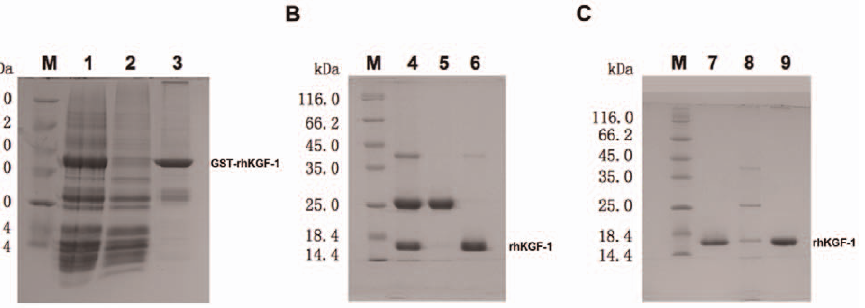
Figure 1. SDS-PAGE analysis of expression and purification of rhKGF-1. Panel A. SDS-PAGE analysis of the fractions collected from Glutathione Sepharose chromatography. Lane M, molecular weight standards; lane 1, the cell lysate supernatant of BL21 (DE3) containing pET- GST- KGF-1 induced with 1.0 mM IPTG for 4 h; lane 2, the flow-through fraction; lane 3, the fraction eluted with 50 mM Tris-HCl, 10 mM reduced glutathione, pH 8.0. Panel B. SDS-PAGE analysis of the fractions collected from CM Sepharose chromatography. Lane M, molecular weight standards; lane 4, the GST-rhKGF-1 fusion protein after treatment with thrombin; lane 5, the flow-through fraction; lane 6, NaCl-eluted fraction. Panel C. SDS- PAGE analysis of Heparin Sepharose chromatography. Lane M, molecular weight standards; lane 7, NaCl-eluted fraction from CM Sepharose Fast Flow column; lane 8, 0.45 M NaCl-eluted fraction; lane 8, 0.6 M NaCl-eluted fraction.